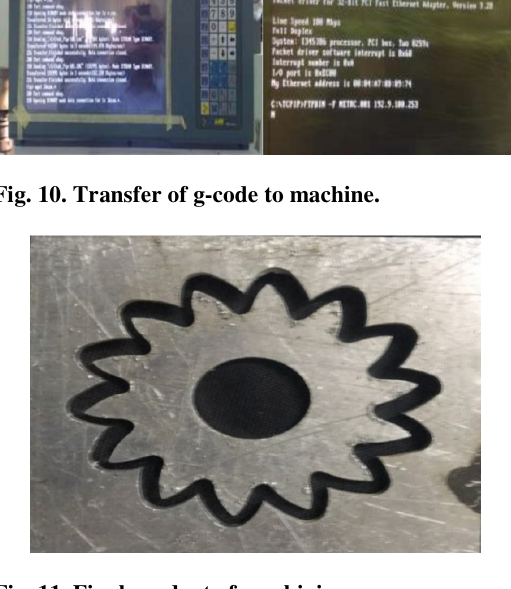
Fig. 11. Final product of machining